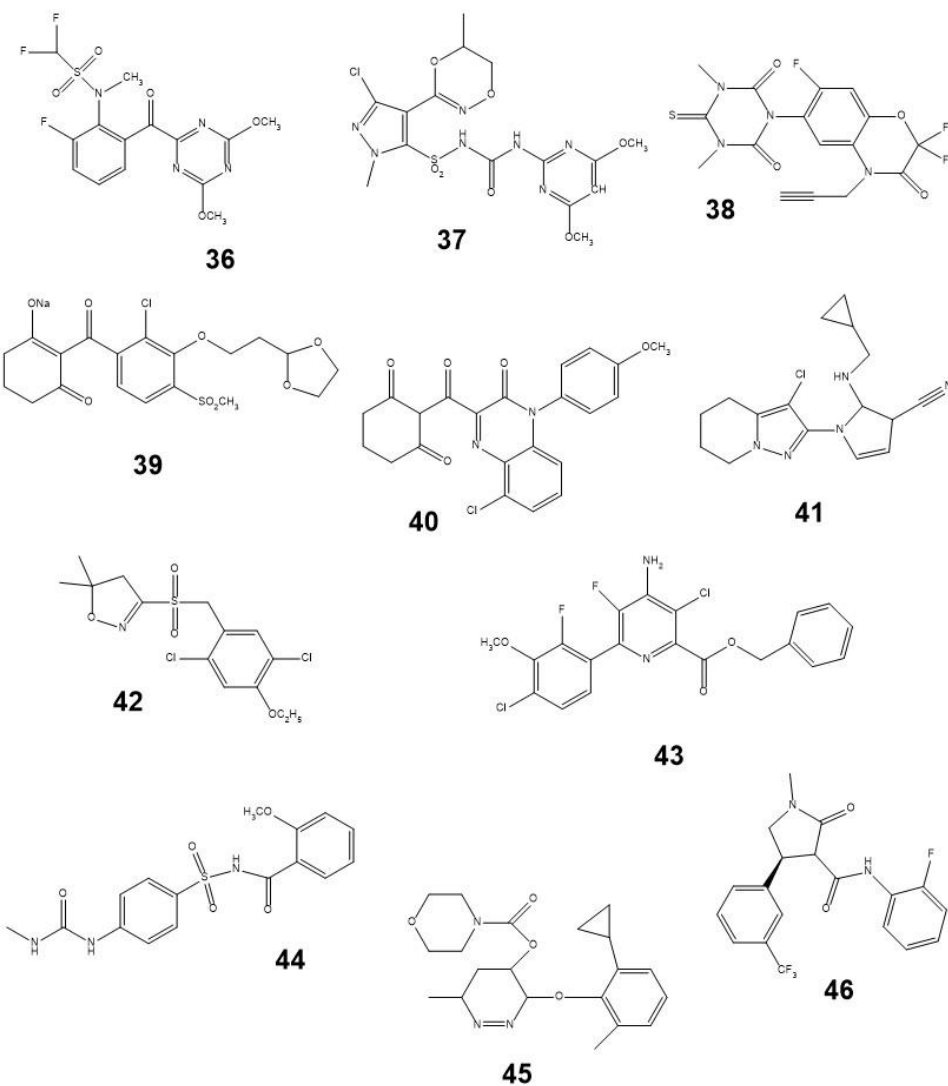
Figure 4. Examples of some new chemical herbicides: 36 — triafamone, 37 — metazosulfurone, 38 — trifludimoxacin, 39 — lancotrione-sodium, 40 — fenquinotrione, 41 — cyclopyranil, 42 — fenoxasulfone, 43 — metcamifen, 44 — florpyrauxifen-benzyl, 45 — cyclopyrimorate, and 46 — tetflupyrolimet.